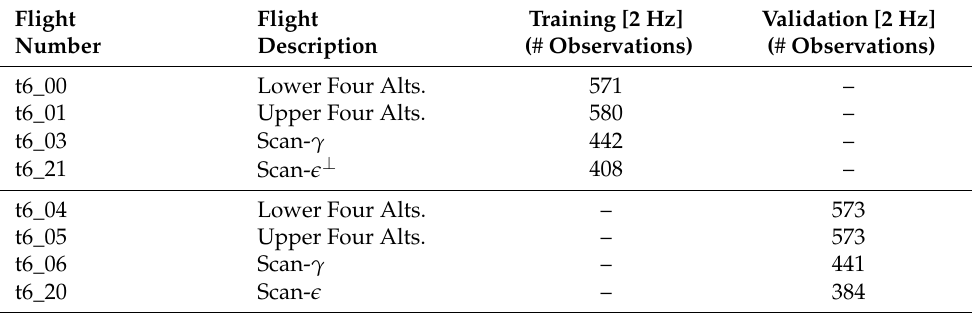
Table 1. Separate flights are used for training and validation. All magnetic field observations were downsampled to 2 Hz for training and validation. The number of observations each training flight contributes to the map is